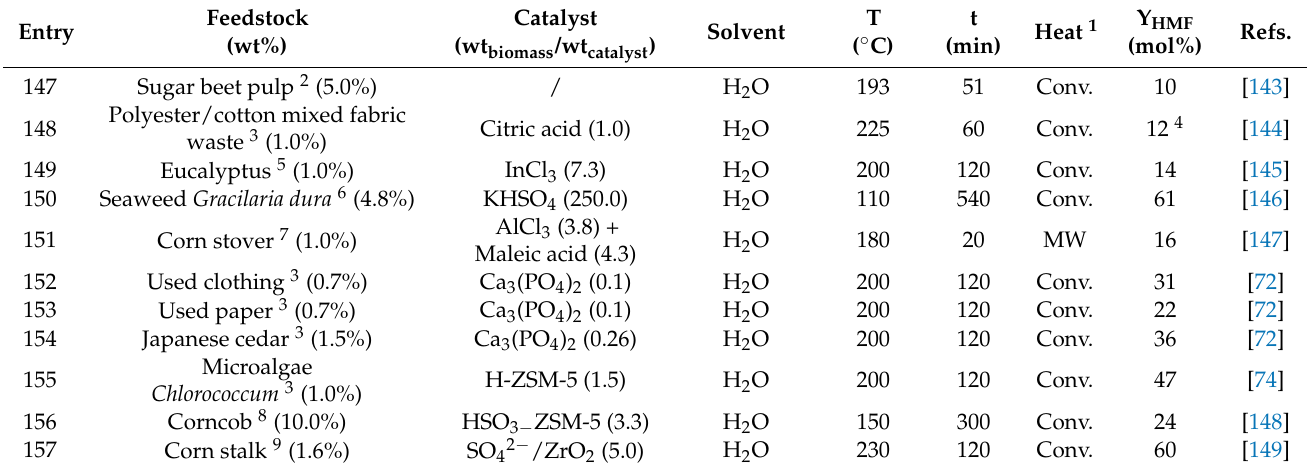
Table 7. HMF production from raw pretreated biomasses in one-solvent